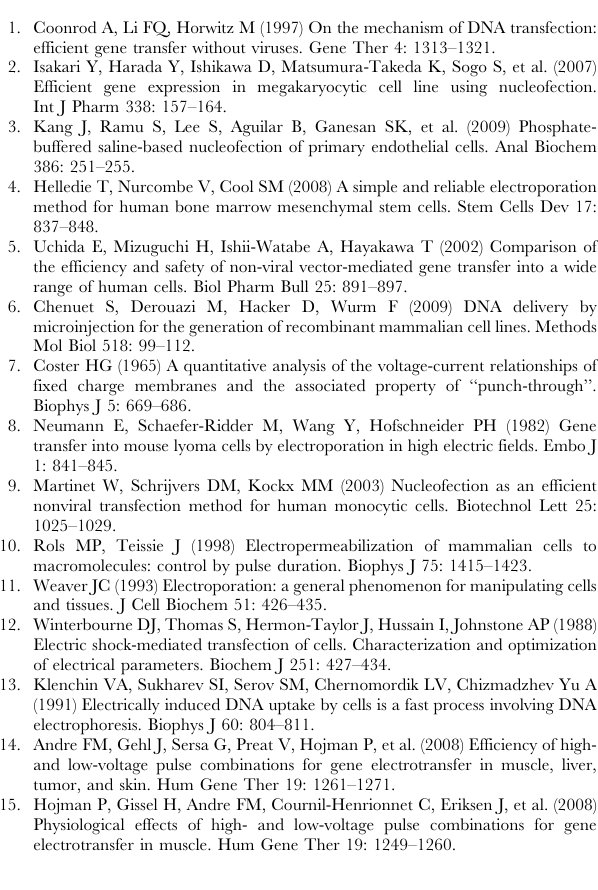
Figure S2 Transfection efficiencies for plasmid DNA to suspension cells after applying a single HV or a combined HV/ LV pulse. Suspension cells from standard cultures (1 6 10 6 ) were transfected with 4 m g pEGFP N1 vector using a single HV pulse (3 kV/cm, 400 m s; bold line) or a combined HV/LV pulse (3 kV/ cm, 100 m s and 750 V/cm, 10 ms; gray area) applied by the ELPorator 1000 device. After 24 h, the transfection efficiency was determined by flow cytometry from the percentages of EGFP + cells and from individual EGFP expression levels according to the MFI values. Light lines show the respective negative control. Viable cell recovery was assessed by trypan blue exclusion. Values given in individual columns are: EGFP + cells as percentage of all cells; MFI x10 3 ; viable cell recovery x10 5 . Data are